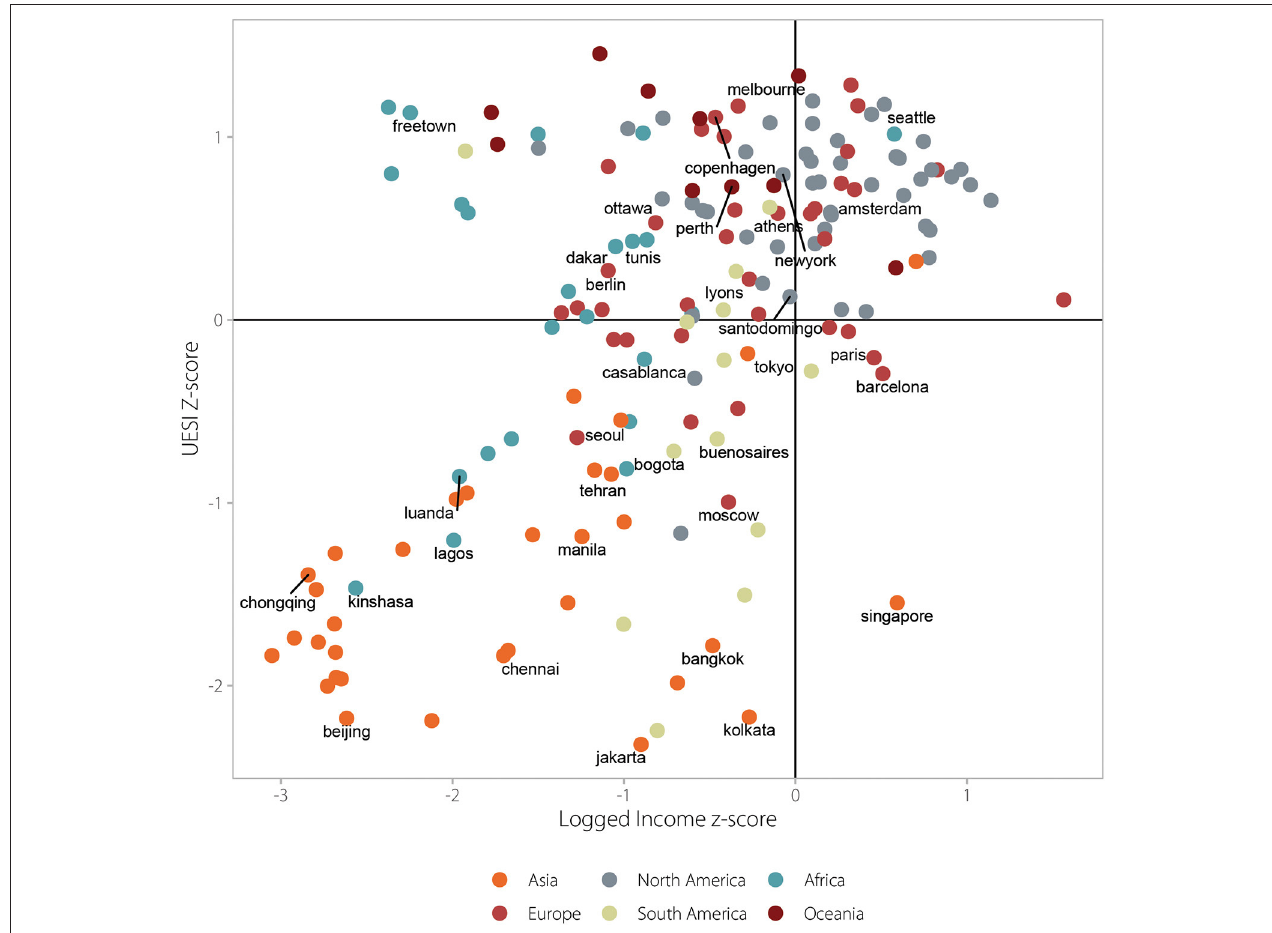
FIGURE 5 | A four-quadrant plot examining the relationship between environmental performance (measured by average z-score of cities’ performance on all UESI indicators) and a z-score of logged income across all city